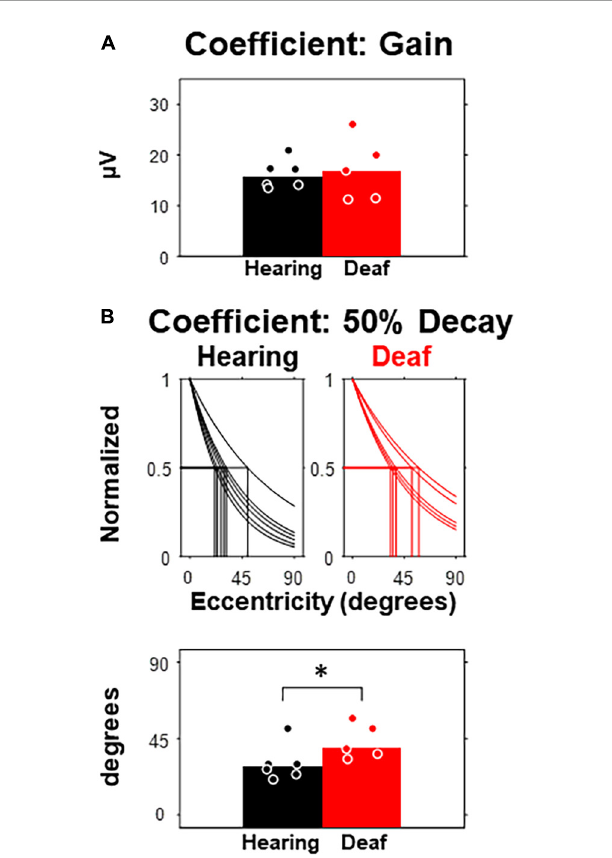
FIGURE4 Comparison of model parameters between hearing and deaf subjects. (A) The fitting coefficient representing the gain of the model, which is equivalent to the model-estimated RMS at central eccentricity. (B) The fitting coefficient representing the rate of decay, which is equivalent to the amount of eccentricity increase that predicts 50% of RMS at central eccentricity. Top, model and 50% thresholds for each subject separated by group. Bottom, 50% threshold compared between hearing and deaf. * p <